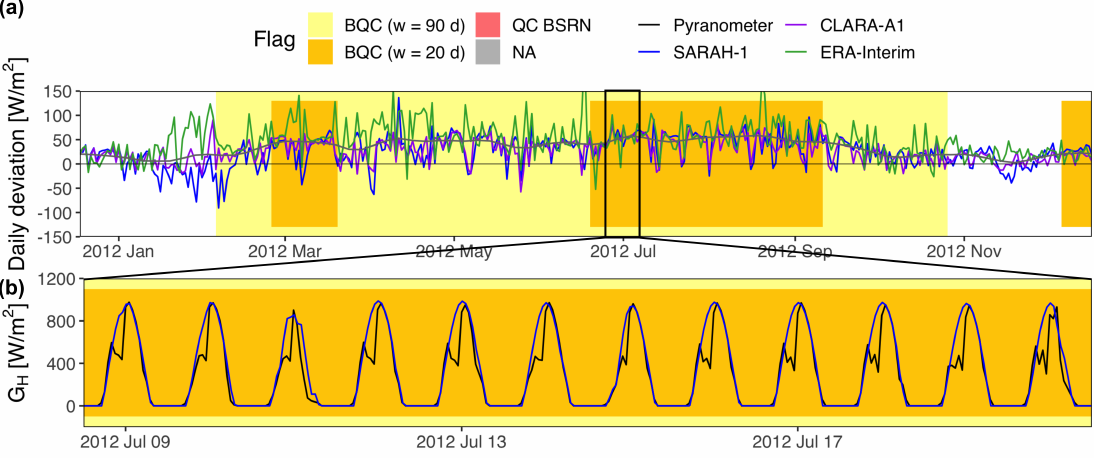
Figure 6. Shadows at SOS Rioja Urbaña station. ( a ) Daily deviations (estimations-measurements) of the radiation databases. The gray line is a smoother of the deviations from the three databases; ( b ) Instantaneous G H from SARAH-1 and the